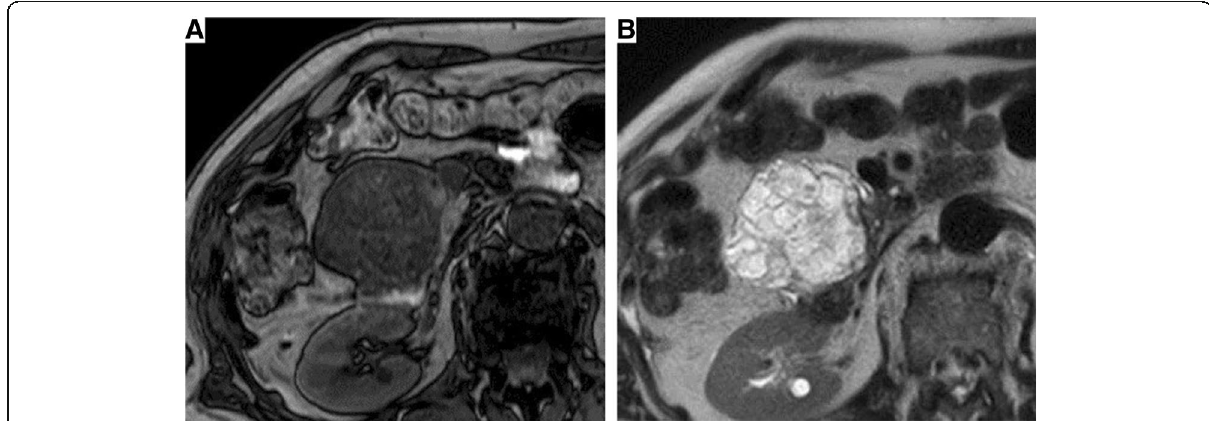
Fig. 2 On magnetic resonance imaging, the microcysts were hypointense on T1-weighted imaging ( a ) and hyperintense with the septum on T2- weighted imaging ( b